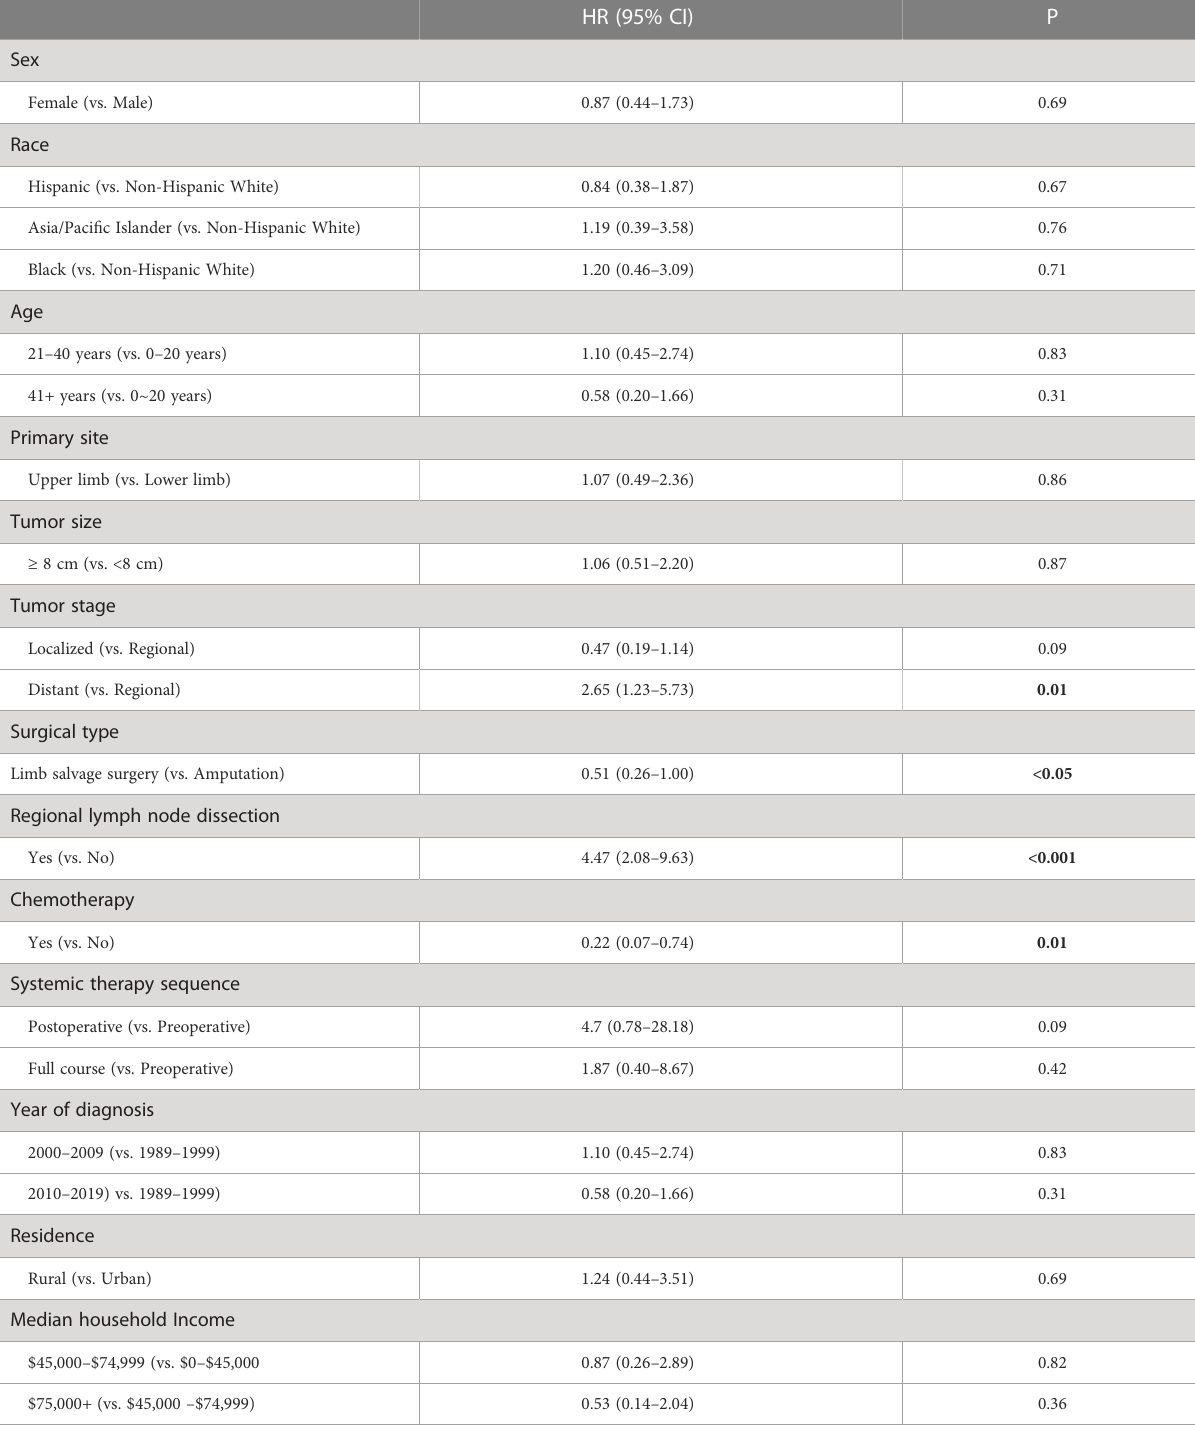
TABLE 2 Univariate analysis of the effect of patient characteristics on